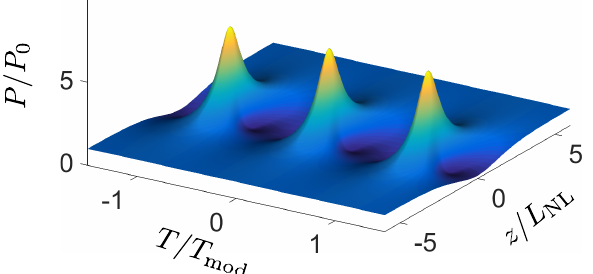
Figure 4. Evolution of an Akhmediev breather at a = 1/4. T mod = 2 π / ω mod